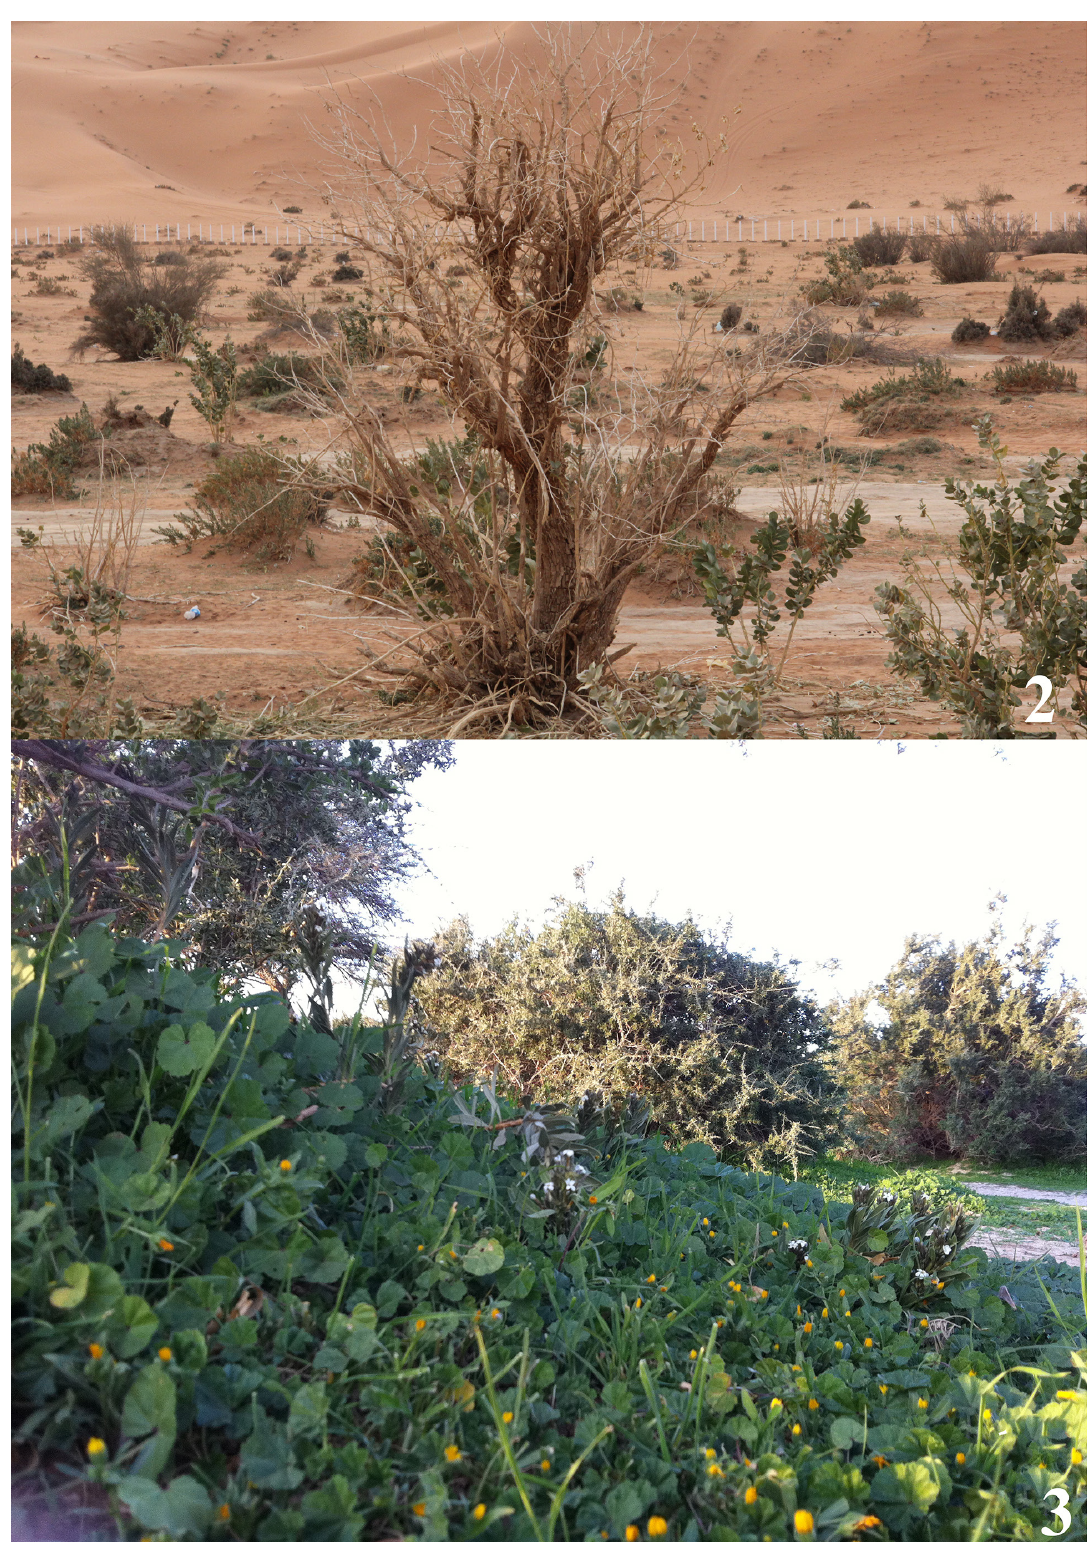
Figs 2–3. Habitats of Oshaibahus zizyphi (Bergevin, 1922) gen. et comb. nov. 2 . Type locality: Muzahimiyah, Al Khararah, KSA. 3 . Additional locality: Rhodet Khorim,